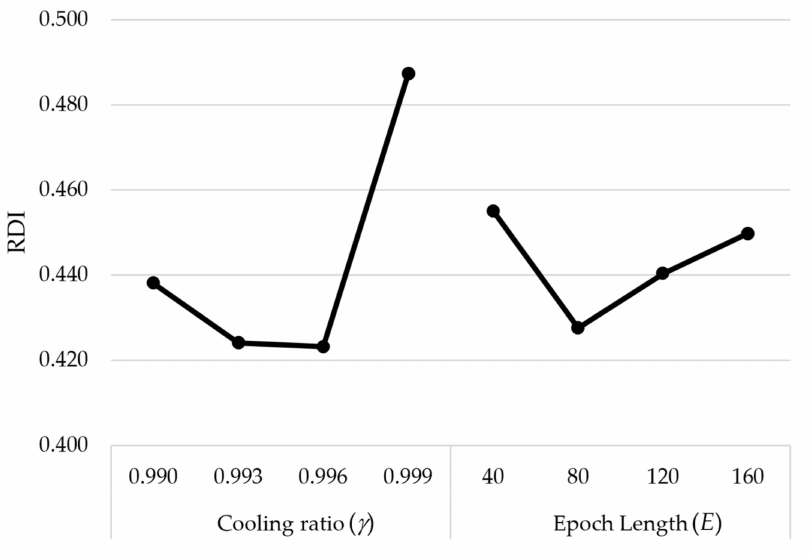
Figure 5. Calibration results of the proposed simulated annealing